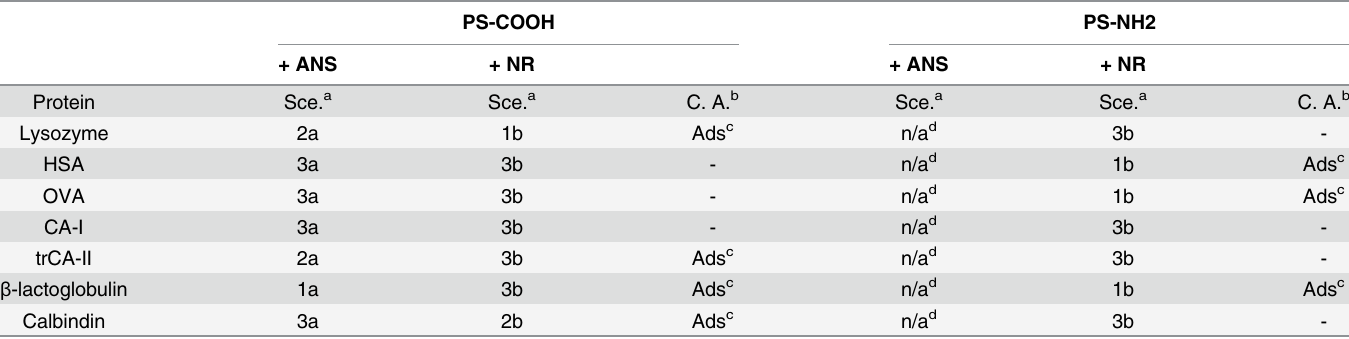
Table 2. Summary of the screening